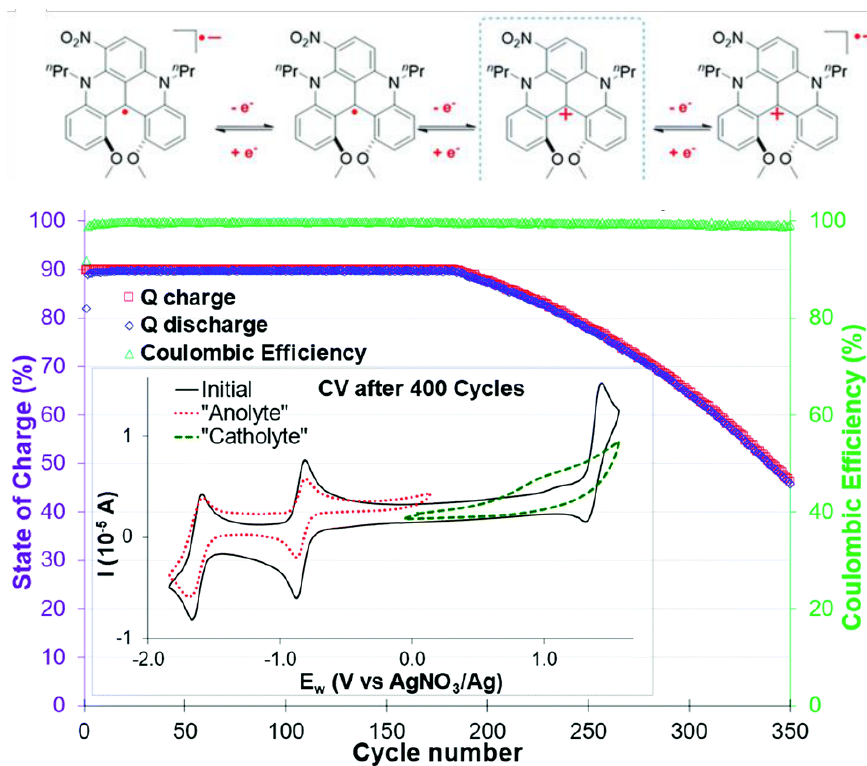
Figure 13. ( Top ) Oxidation and reduction mechanism for dimethoxyquinacridinium ( B8 ) and ( bottom ) monitoring of the capacity of charge/discharge cycles and the Coulombic efficiency over 350 cycles of mono − electronic exchange at a 5 mA current in a symmetric H − cell. Inset: cyclic voltammogram before and after 800 cycles (0.1 M dimethoxyquinacridinium and 0.1 M TBAPF 6 supporting electrolyte in acetonitrile). Reproduced with permission from Moutet et al. [114], copyright Royal Society of Chemistry 2022.